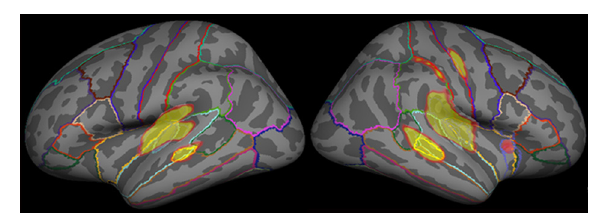
FIGURE 1 | The grand averaged functional map evoked by emotional syllables. The functional map of dSPM solutions estimated for each category (emotional syllables, complex, and simple tones) was superimposed onto a reconstructed anatomical criterion where the vertices were optimally parceled out using the gyral-sulcal patterns. We overlaid the grand averaged functional map in response to emotional syllables onto the common reconstructed cortical sphere as an example.